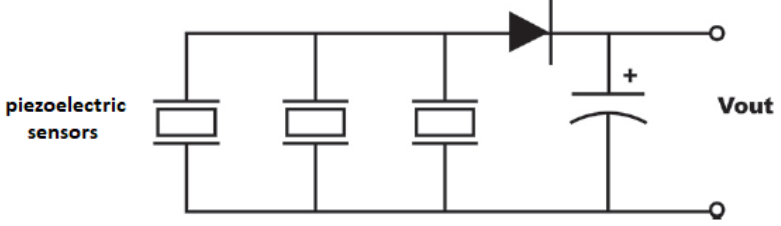
Figure 13. Improved circuit to store and deliver